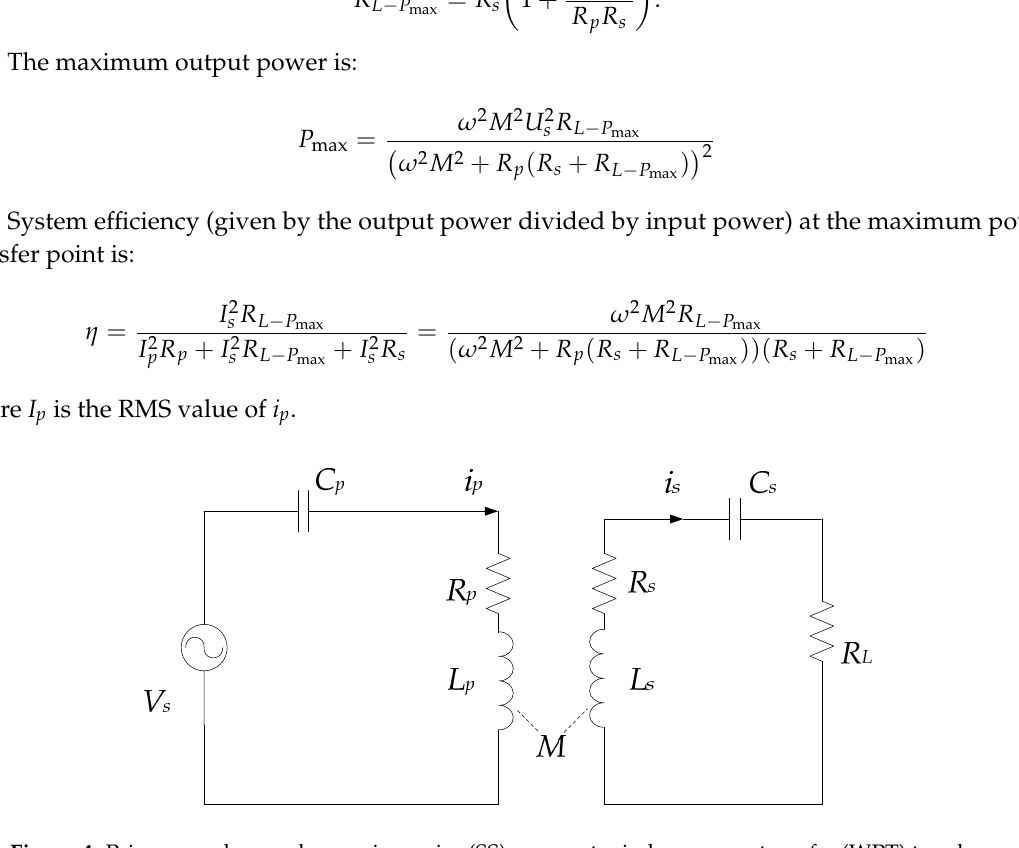
Figure 4. Primary and secondary series-series (SS) resonant wireless power transfer (WPT) topology.